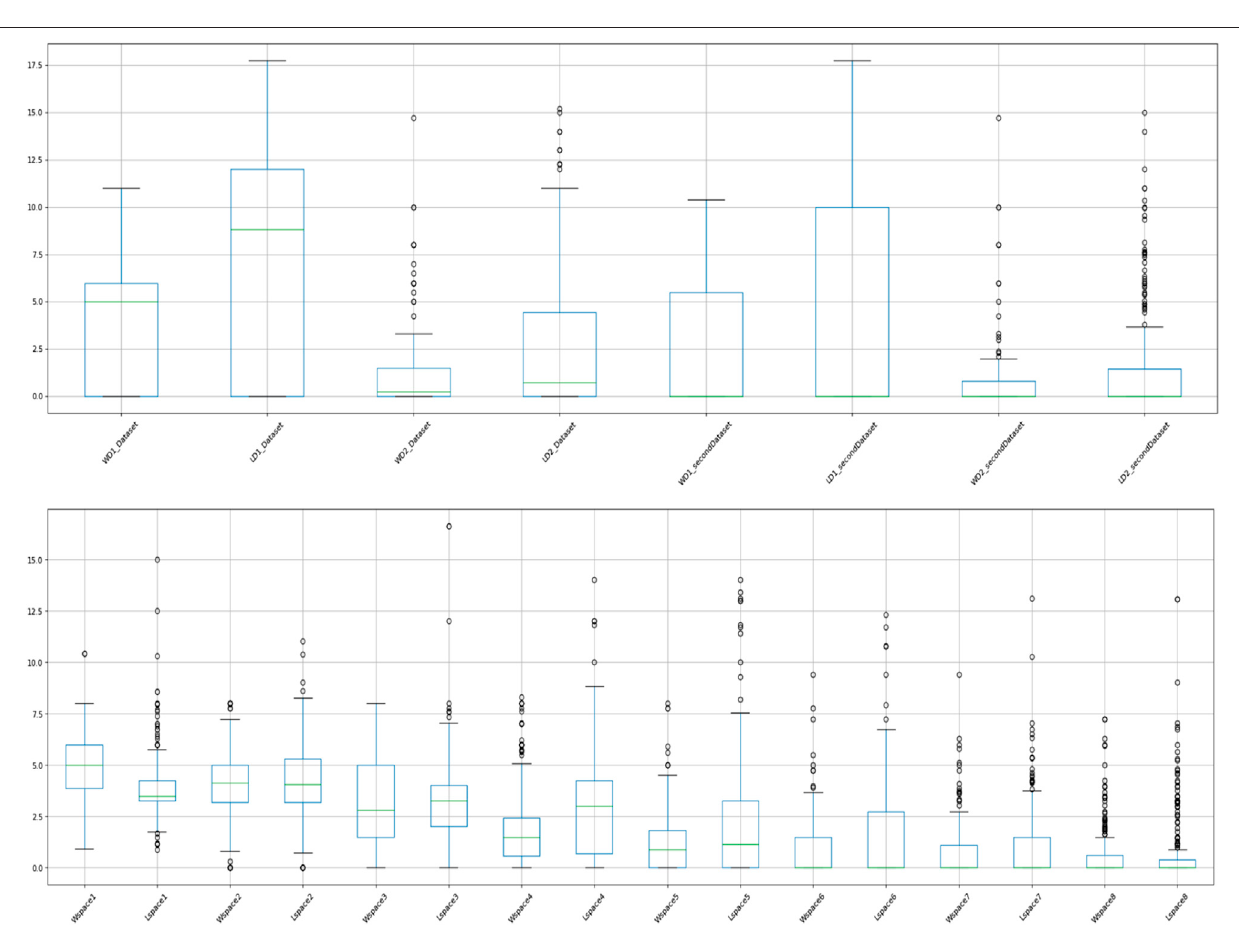
FIGURE 5 | Review of the data structure of plans (Boxplot), Source: